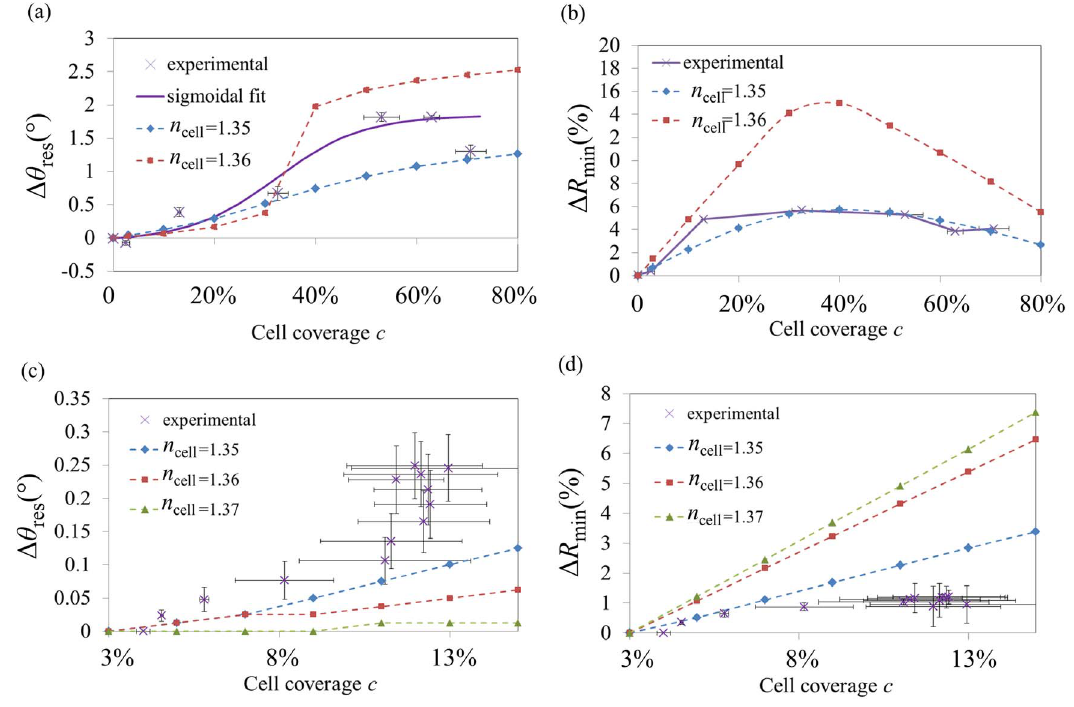
Figure 5. Comparison of cSPR parameters from experimental studies to those predicted by the averaged-intensity cSPR model. Dependence of h res (a) and R min (b) with respect to the cell coverage. Dependence of h res (c), and R min (d) with respect to the spreading of cells. The simulations are plotted in dashed curves ( n cell =1.35: diamond, n cell =1.36: squares, n cell =1.37: triangles). Fitting the linear parts in (a) yielded n cell =1.3483 (by quadratic extrapolation of the slopes). Error bars represent the standard errors.